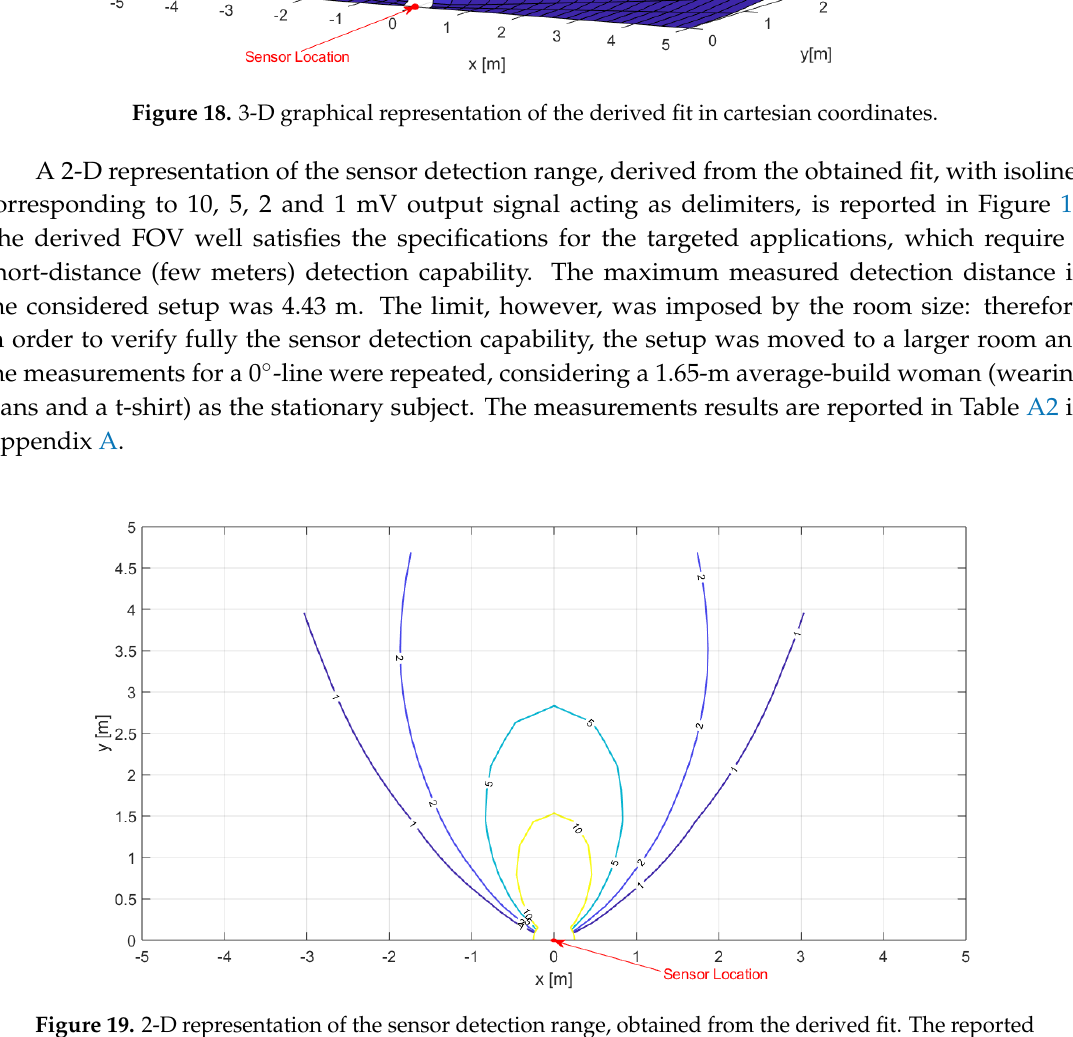
Figure 19. 2-D representation of the sensor detection range, obtained from the derived fit. The reported lines are the isolines corresponding to an output signal equal to 10 mV, 5 mV, 2 mV and 1